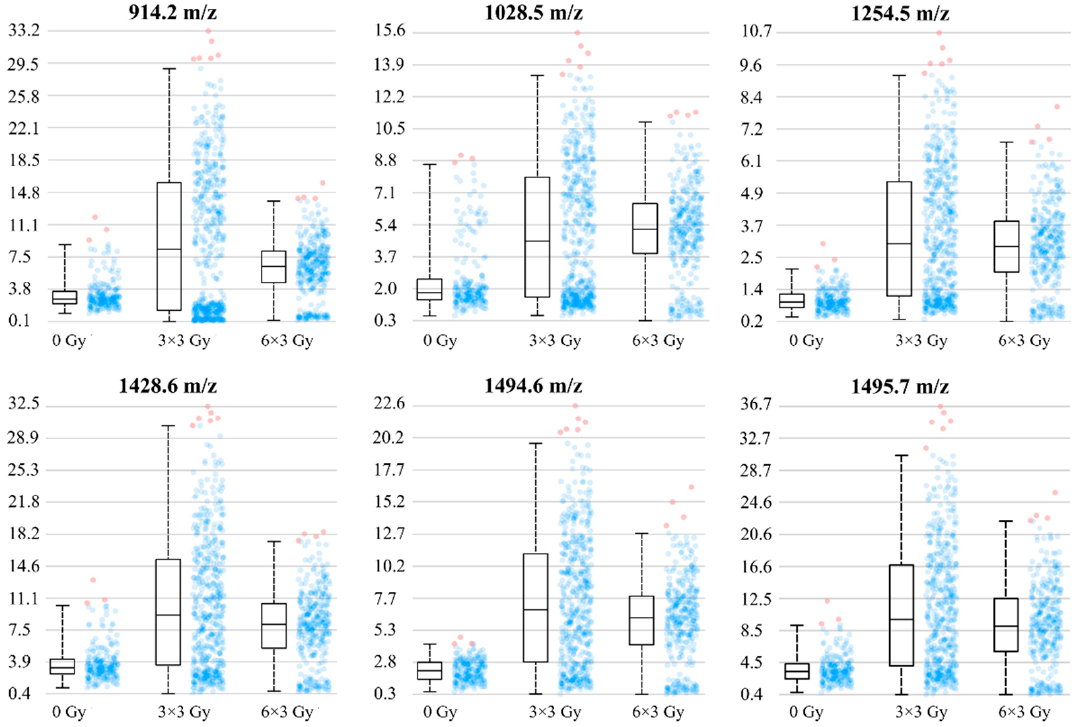
Figure 6. The intensity blots of tumor-specific masses are presented for differently treated G7_mCherry orthotopic brain tumors. Intensities of tumor masses increased after irradiation with three fractions of 3 Gy, suggesting a more pronounced invasion front after irradiation. Higher radiation doses of six fractions of 3 Gy did not enhance those effects. After irradiation, a broader range of intensities was shown for tumor measurement spots (dots displayed on the right of the box), suggesting a higher range of intratumoral heterogeneity of mass occurrence.